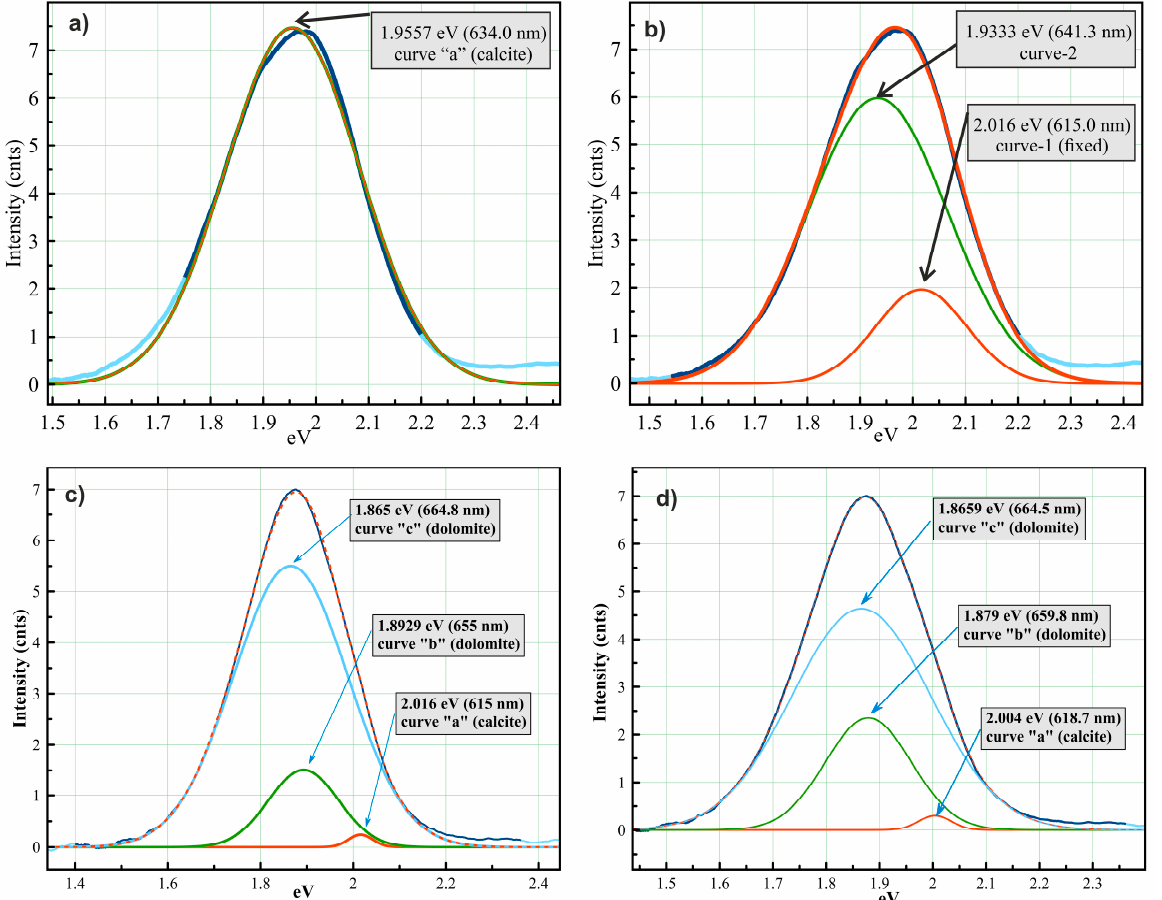
Figure 7. Examples of spectra fitted by single ( a ), two ( b ) and three ( c , d ) Gaussian curves. The plots represent two spectra, calcite ( a , b ) and dolomite ( c , d ). Both spectra represent “anomalous” spectra of each mineral in two respects: (i) they represent spectra with the highest value of the maximum position (centre) of a single Gaussian curve of each mineral group; (ii) the main CL-band is asymmetric and is therefore better fitted by two or three Gaussian curves than by a single curve. Individual curves are labelled by the position of their centres (maxima). The dolomite spectrum was fitted twice, first with the centre position of two curves fixed at 615 (curve “a”) and 655 (curve “b”) nm, based on the typical position corresponding to Mn-extrinsic luminescence in calcite and dolomite, respectively. The position of the third curve “c” was “unfixed” and therefore varies from spectrum to spectrum. ( d ) The deconvolution of the same dolomite spectrum as in ( c ), but all curves were allowed to fit the spectrum freely.